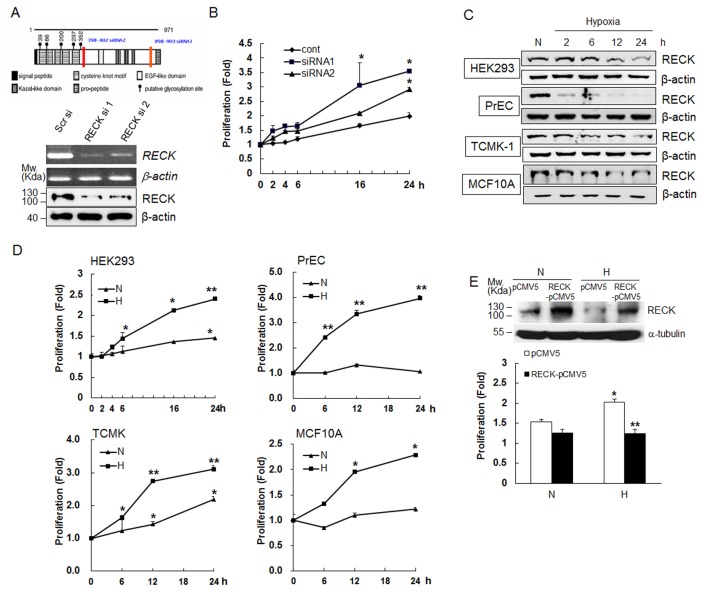
RECK silencing induced by hypoxia stimulated epithelial cell proliferation.(A) Site and silencing efficiency of two RECK siRNAs. The upper panel shows RECK siRNA sites (red bar). The lower panel shows that transfection of RECK siRNAs (5 nM) into HEK293 cells effectively blocked RECK expression. The experiment was performed in triplicate. (B) Proliferation assays were performed at 24 h post-transfection (0 time) at the indicated times after seeding siRNA-transfected cells at 5x103 per well in 96-well plates. Fold change is the ratio of the cell population at each time point versus the start time (point 0). Data are presented as means ± SDs (n=4). *, p<0.01 versus scrambled-transfected controls. (C) Total protein lysates were extracted from HEK293, PrEC, TCMK, and MCF10A cells after exposure to normoxia or hypoxia for the indicated times. RECK expressions were determined by western blotting. β-actin was used as an internal control. (D) HEK293, PrEC, TCMK, and MCF10A cells were plated at a density of 5x103 in 96-well plates. After 24 h, cells were maintained under normoxic (N) or hypoxic (H) conditions for the indicated times. Cell proliferation assays were performed using a CCK-8 cell proliferation assay kit. Data are presented as means ± SDs (n=4). *, p<0.01, **, p<0.001 versus normoxic controls. (E) Full-length pCMV5-RECK plasmids were transfected into HEK293 cells, and RECK protein levels and cell proliferation rate were determined by Western blot analysis and CCK-8 cell proliferation assay kit, respectively, after incubation under normoxic (N) or hypoxic (H) conditions for 24 h. Data are presented as means ± SDs (n=3). *, p<0.01, versus normoxic controls, **, p<0.01 versus hypoxic controls. All experiments were performed at least three times.